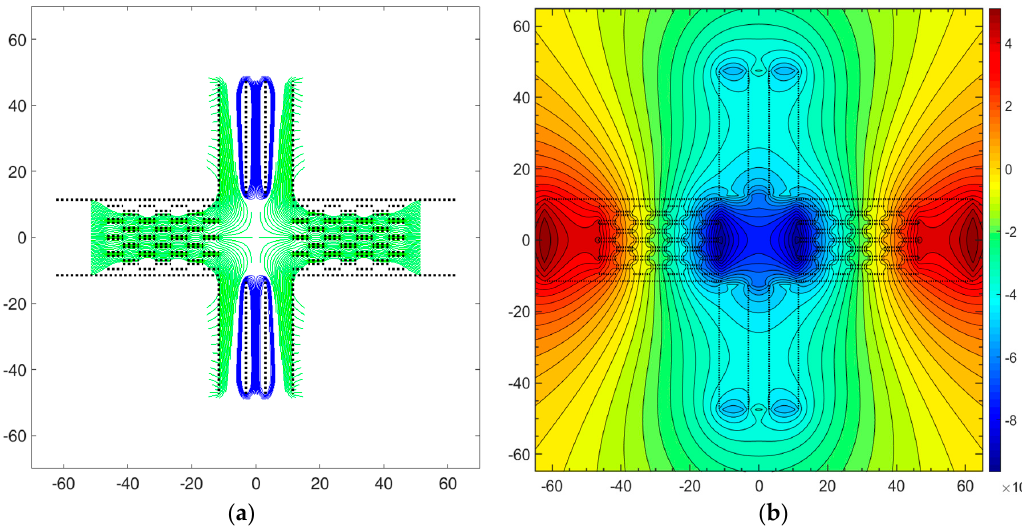
Figure 10. ( a ) Streamlines and stream function solution (color grades) for mud circulating down the drill string and up the annulus. Minor circulation occurs outside the annulus, which is an artifact of the model method. ( b ) Corresponding potential function solution. Length units are scaled in cm (both x-axis and y-axis).